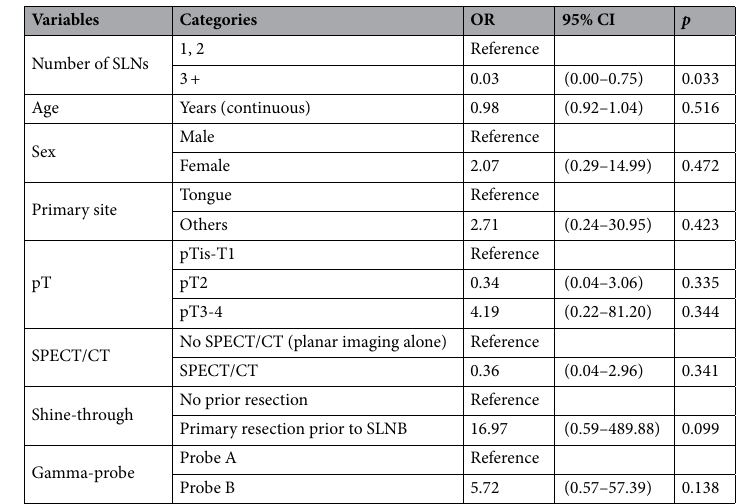
Table 5. Association between clinical factors and false-negative results. OR: Odds ratio. CI: Confidence interval. SLN: sentinel lymph node. SPECT/CT: single-photon emission computed tomography/computed